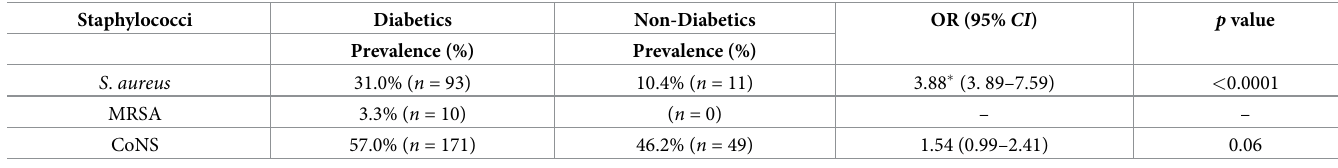
Table 3. A comparison of the study participants on their staphylococcal carriage.